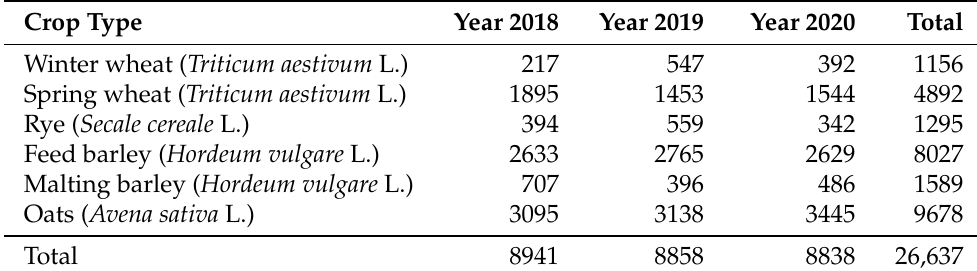
Table 1. Number of farms in the sample sets for all studied crops in 2018–2020. Crop